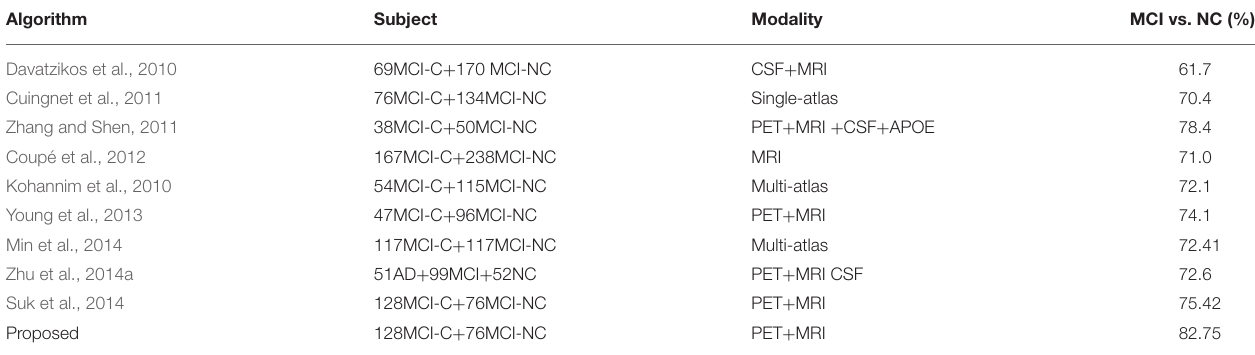
TABLE 4 | Algorithm comparison for MCI-C vs. MCI-NC classification